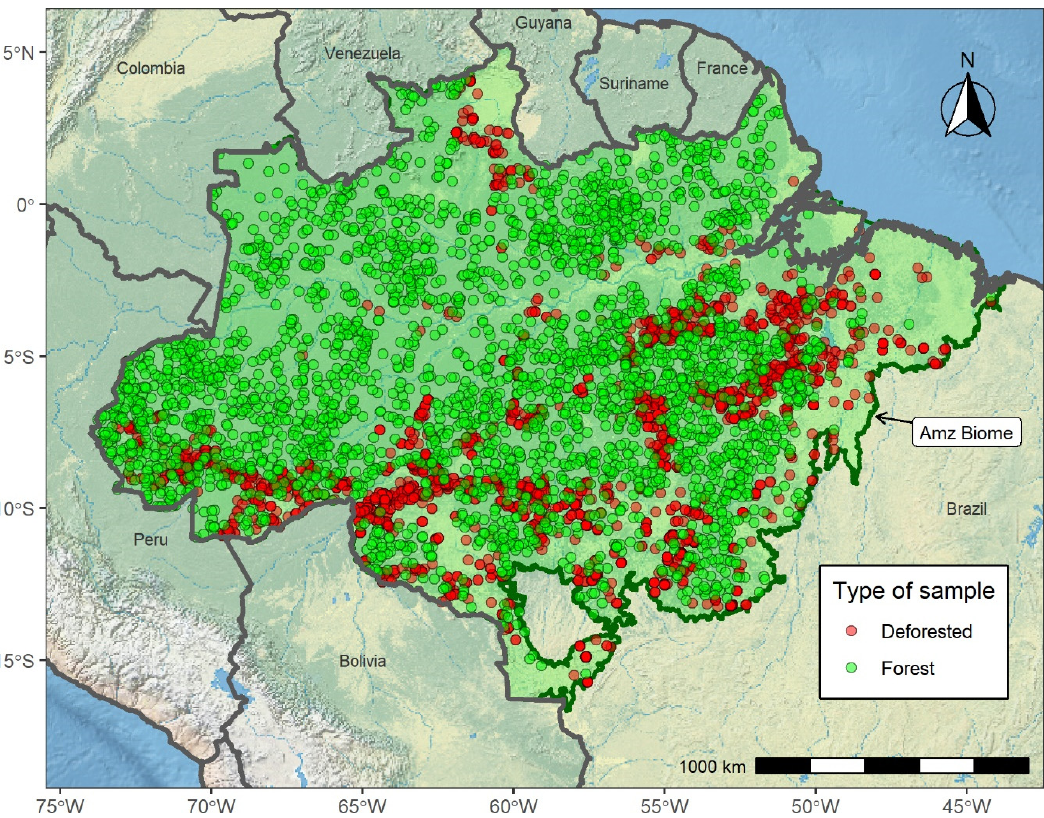
Figure 2. Map of the sampling locations used during this research.